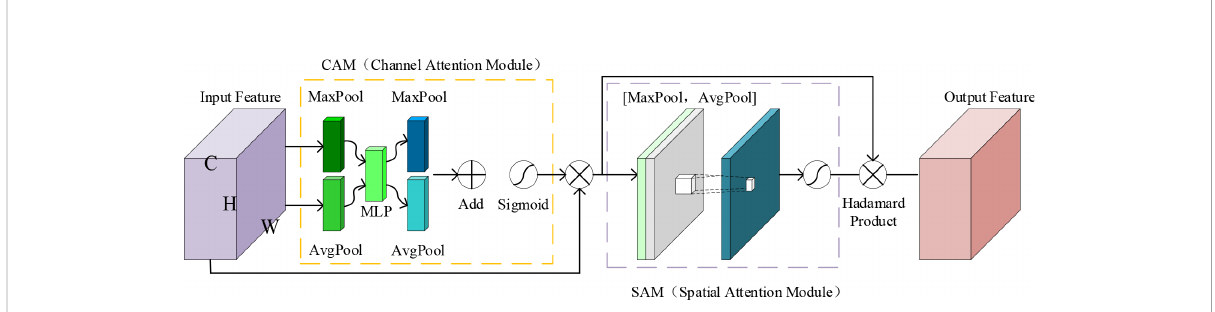
FIGURE 6 Structure of the CBAM. The left part represents the channel attention module and the right part represents the spatial attention module. The feature map passes fi rst through the left part and then through the right